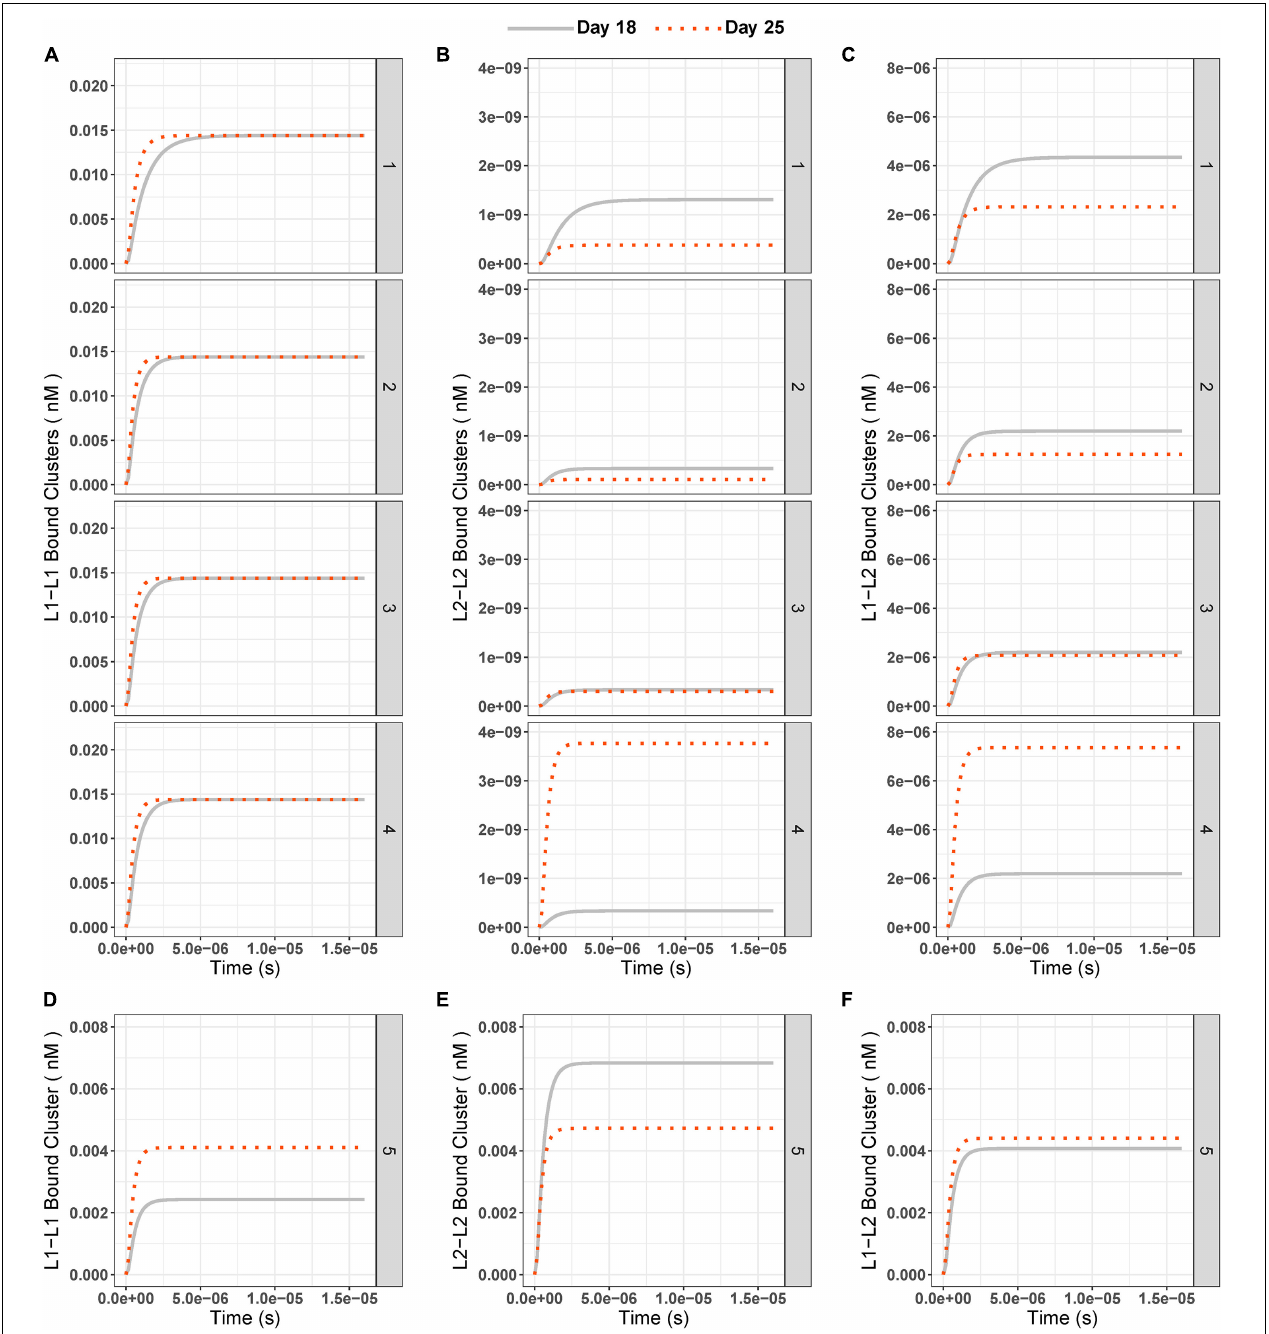
FIGURE 5 | (A–C) Concentrations of ligand-bound integrin clusters L 1– L 1 (left column, A-1 to A-4 ), L 2– L 2 (middle column, B-1 to B-4 ), and L 1– L 2 (right column, C-1 to C-4 ) over time at days 18 (gray solid line) and 25 (red dotted line) for all test conditions (1–5). (D–F) Integrin cluster concentration over time for condition 5 (Different IC ( L 1 = 0.18 nM, L 2 = 0.33 nM) and equal binding rate constants ( k 3 = k 5 = 1.6 × 10 8 1/nM × s, k 4 = k 6 = 3.5 × 10 - 1 1/s) for ligands).